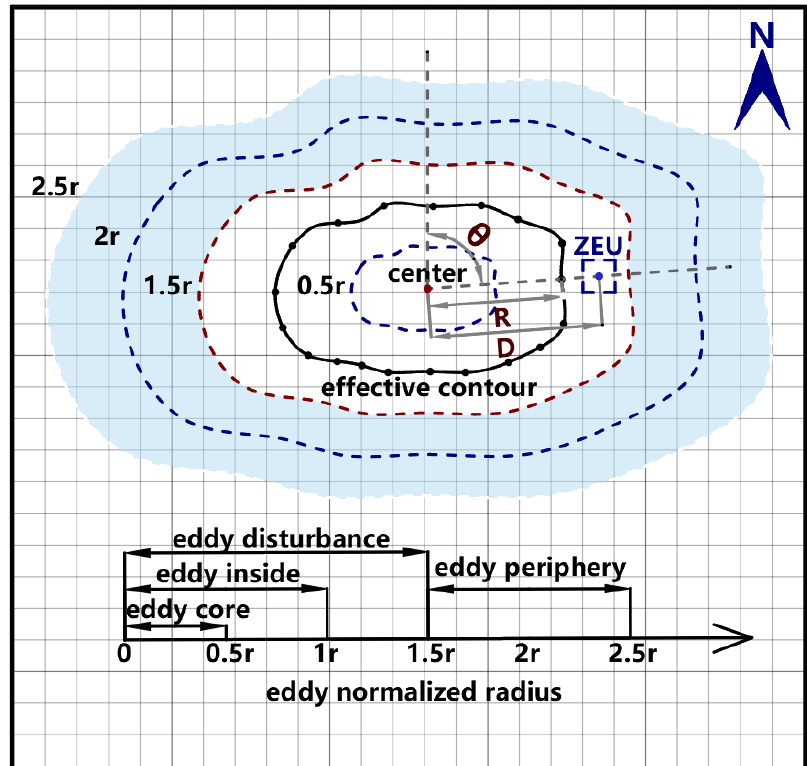
Figure 1. Schematic diagram of normalized radius calculation. Each grid represents a ZEU grid data, the grid center is approximately the geographic coordinate of the grid data, and the irregular circle is the effective boundary of the eddy with different radius. The distance between the eddy center and ZEU data point is D, and the distance between the eddy center and the eddy effective contour is R, and the azimuth angle between the eddy center and the data point is θ.